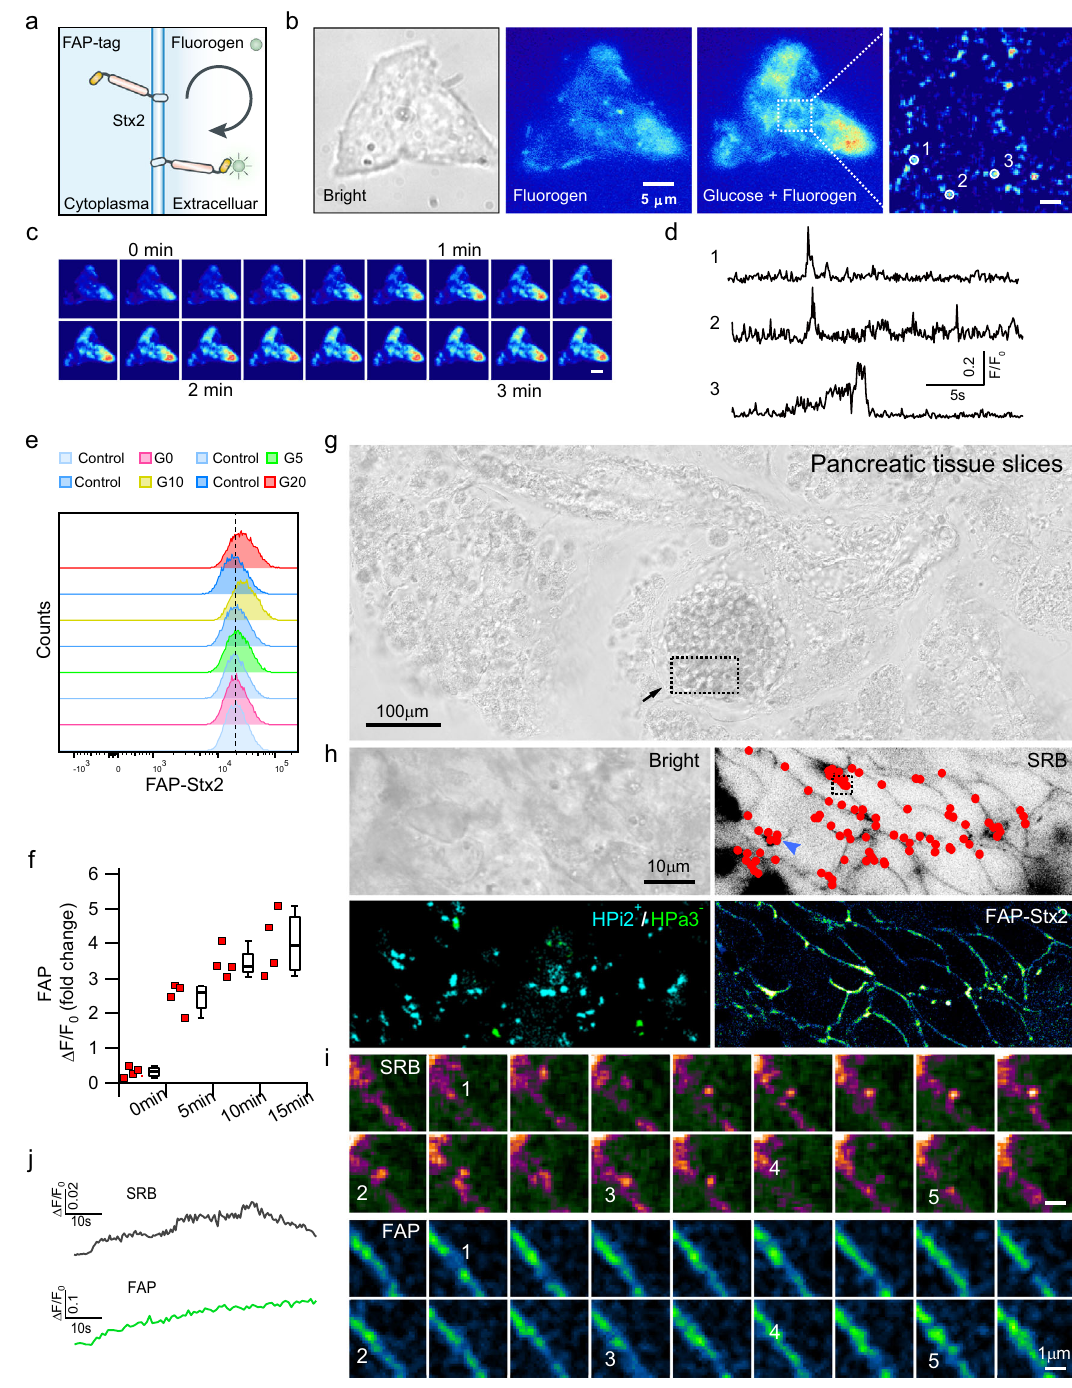
Fig. 4 | Stx2 fl ips from the inner to the outer surface of the cell membrane in human β -cells.a Schematicrepresentationofthegeneticallyencoded fl ipreporter for monitoring Stx2 fl ipping. b INS832/13 cells were infected with FAP-Stx2, sti- mulatedwithhighglucoseandvisualizedbyTIRFmicroscopy. c Time-lapseimages showtheglobalStx2 fl ip-outofthecellin b .Scalebar,5 µ m.Montagesareshownat ~10-s intervals. d Representative time course of single Stx2 fl ipping events on INS832/13 cell surface ( n =3 independent experiments). e Assessment of Stx2 on the extracellular surface of single human β -cells analyzed by fl ow cytometry. f Quanti fi cation of Stx2 fl ip-out with the results from e ( n =4 independent experi- ments, box plots indicate median, 25th, 75th percentile and whiskers min/max limits). g Light micrograph of fresh human pancreatic tissue slice. h Simultaneous imaging of Stx2 fl ip-out (FAP) and exocytosis (aqueous tracer SRB) in human pancreatic tissue slices. Human pancreatic tissue slices infected with FAP-Stx2 for 48h, then labeled with primary and secondary antibodies (see methods). ROI